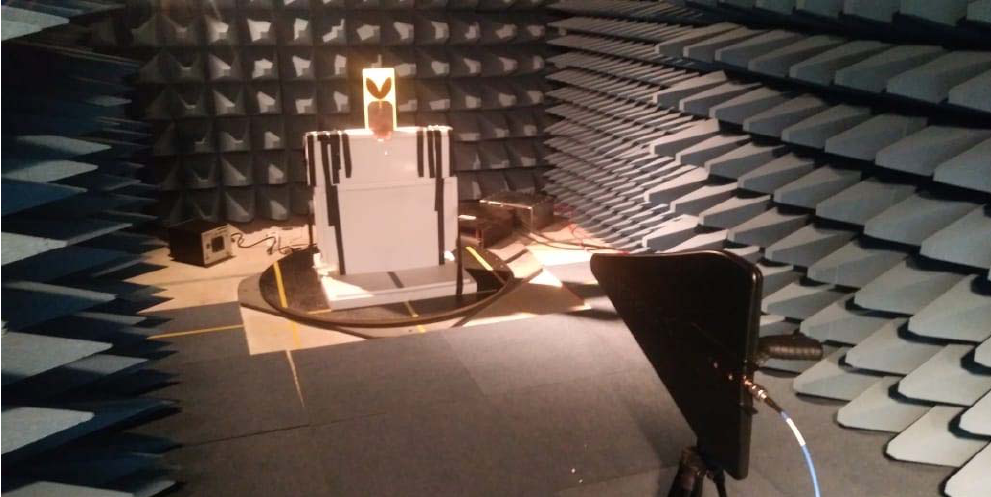
Figure 6. Gain measurement setup in the anechoic chamber.